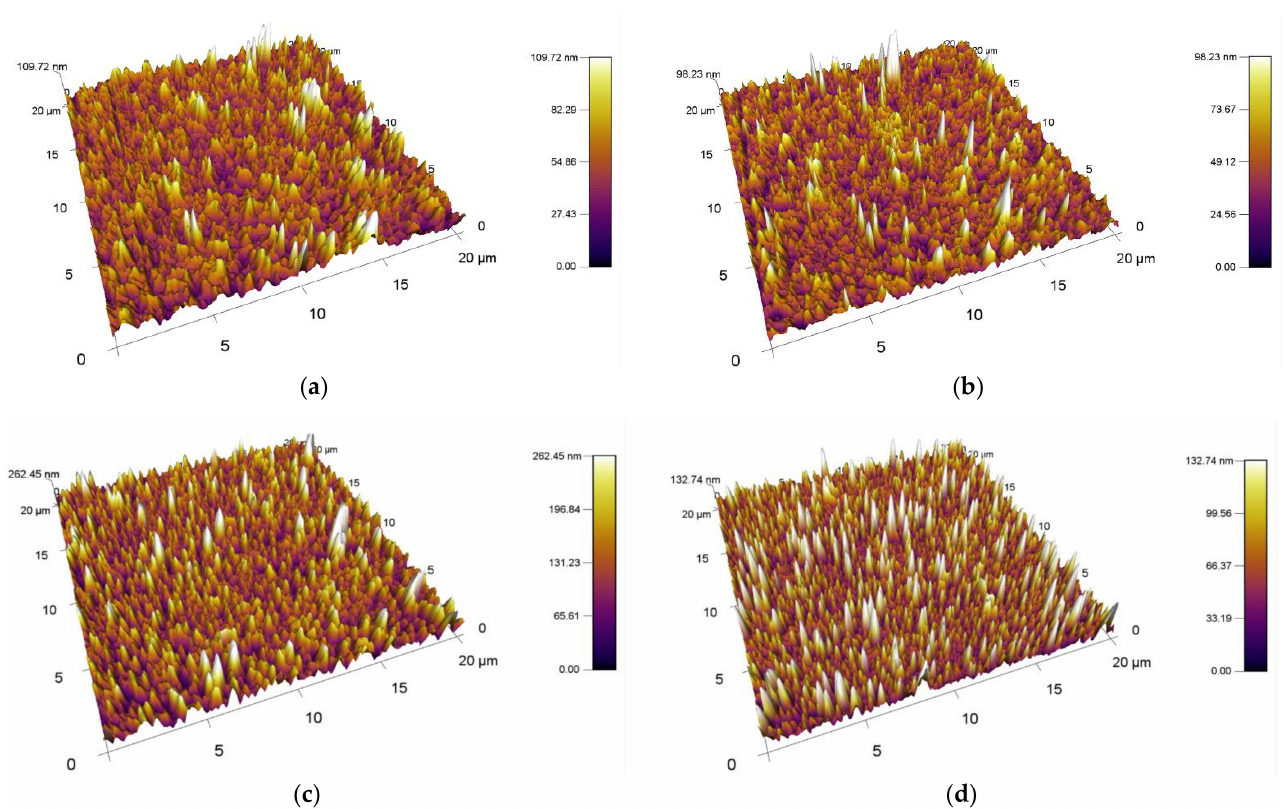
Figure 8. AFM images of plasma modified (modification type 1: DUAL) surfaces of PVC. From the left exposure types, ( a ) I, ( b ) II, ( c ) III, ( d )